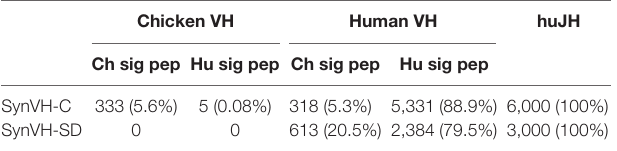
Table 2 | SynVH-C but not SynVH-SD showed gene replacement by chicken VH, whereas both had changes in the signal peptide.